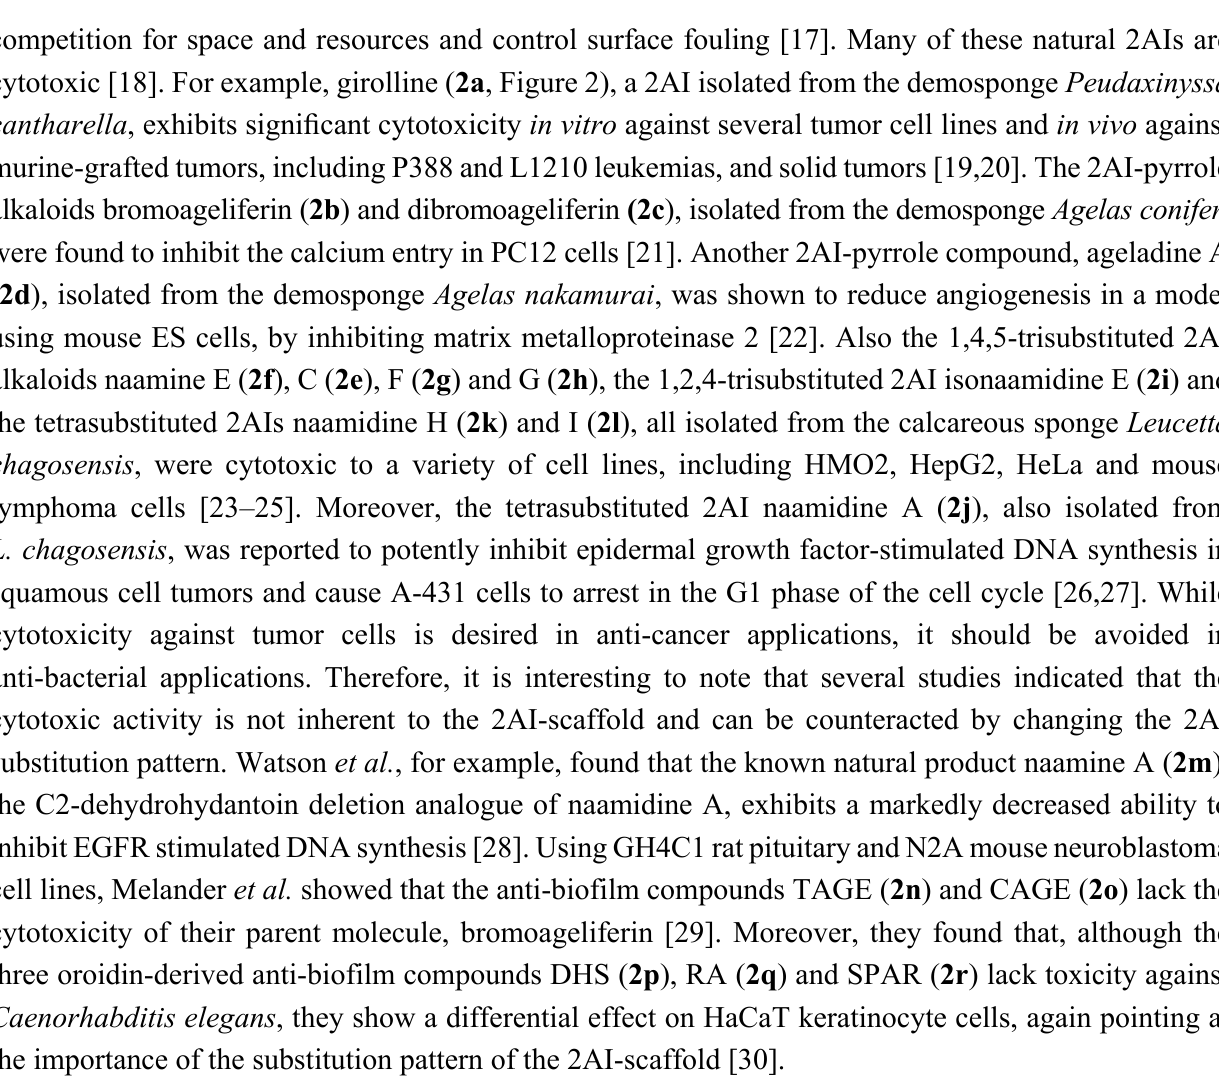
Figure 1. Classes of 5-aryl-substituted 2-AI with anti-biofilm activity reported by our lab